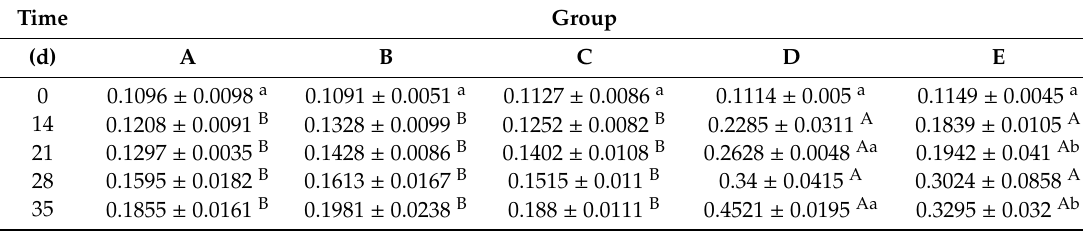
Table 2. The OD 450 of SIgA levels before and after